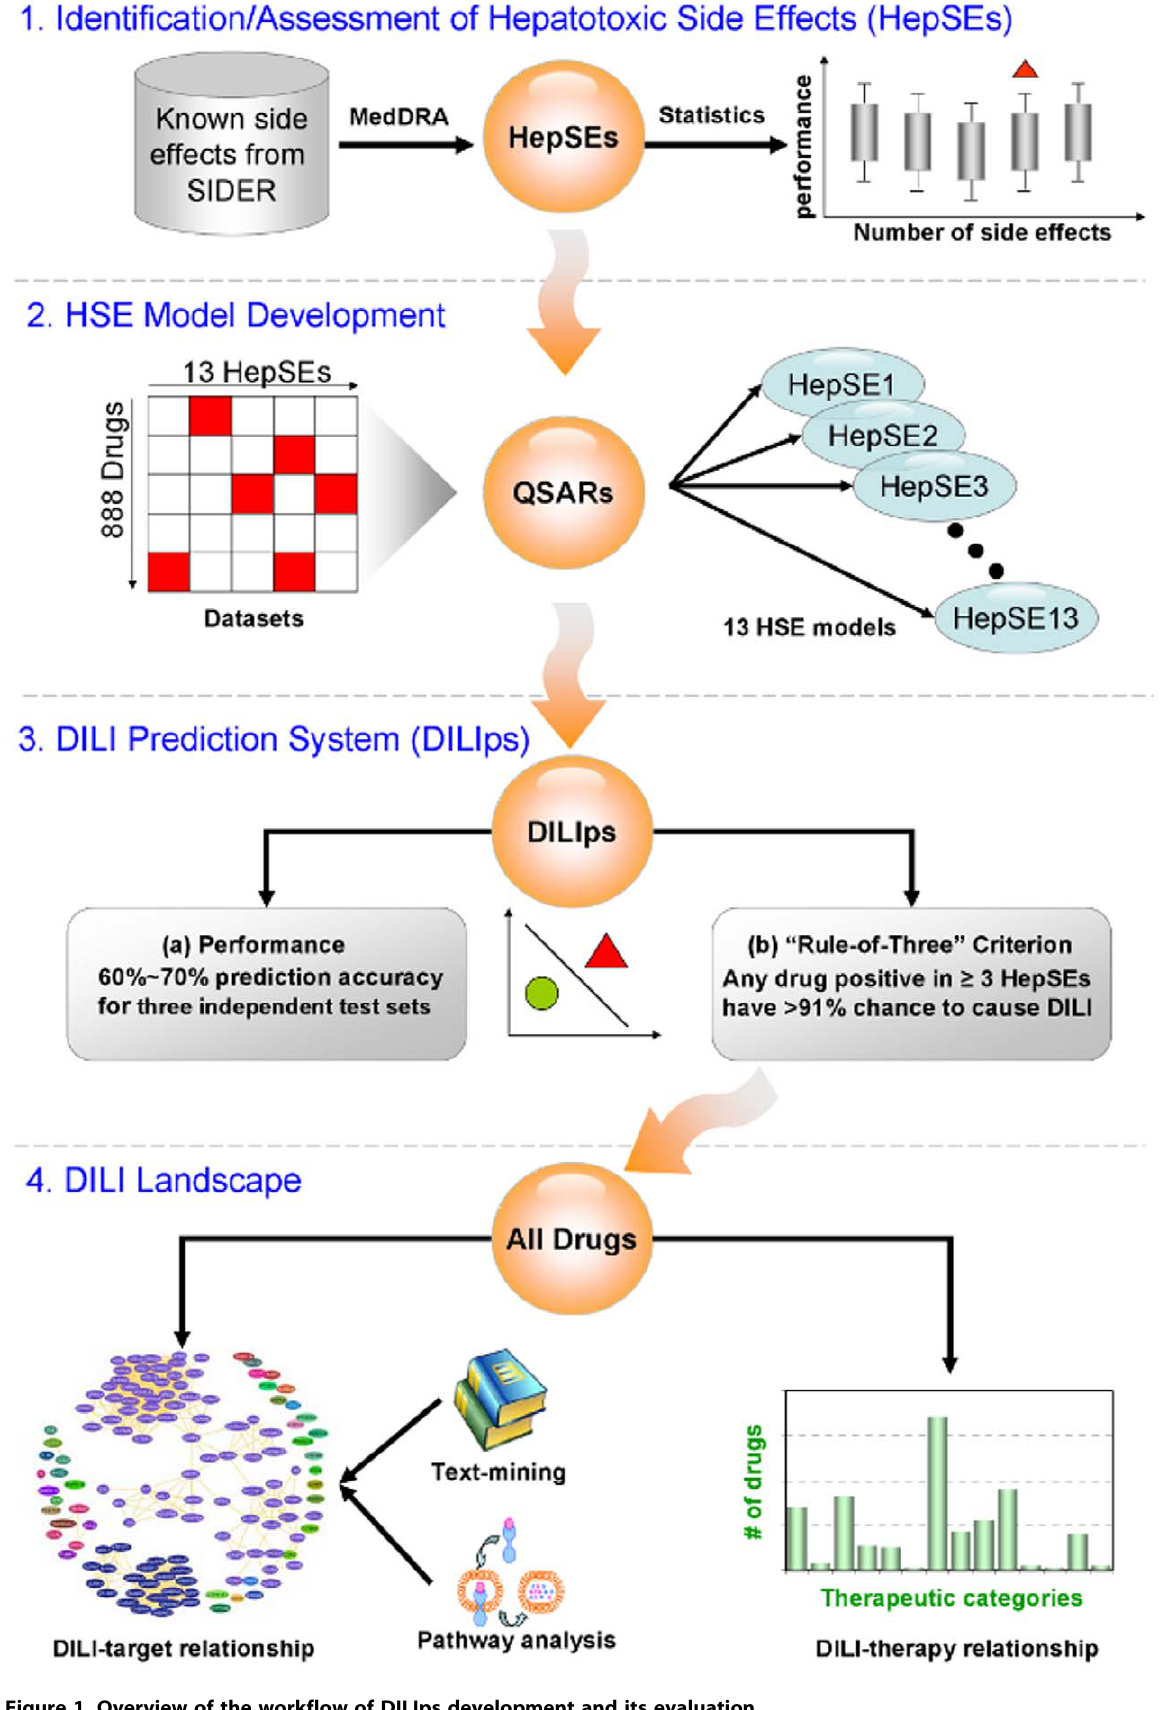
Figure 1. Overview of the workflow of DILIps development and its evaluation. doi:10.1371/journal.pcbi.1002310.g001 PLoS Computational Biology |